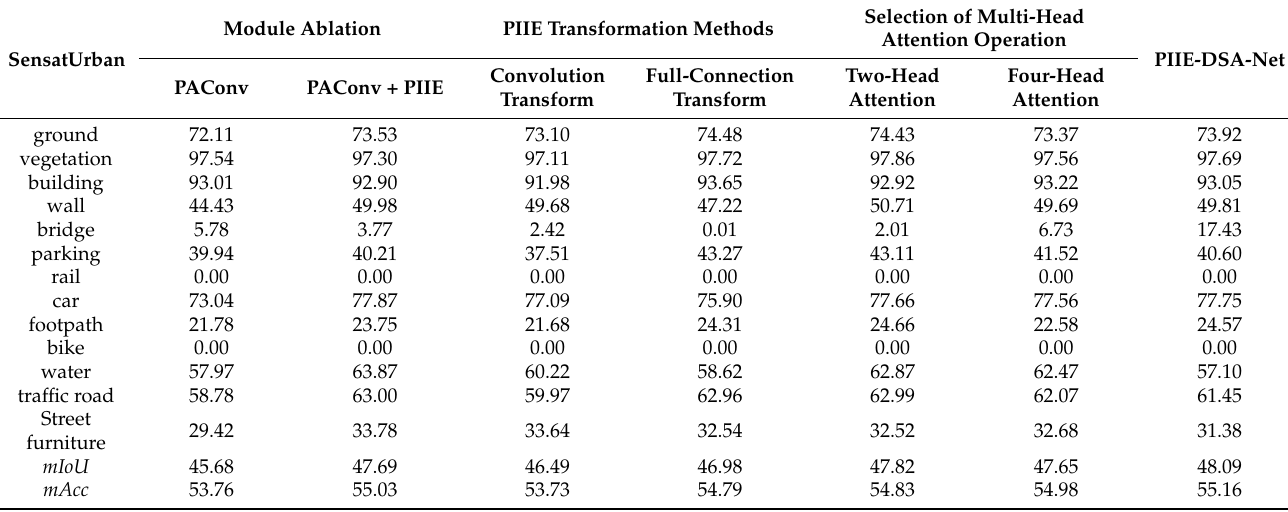
Table 6. The experiments on the SensatUrban dataset